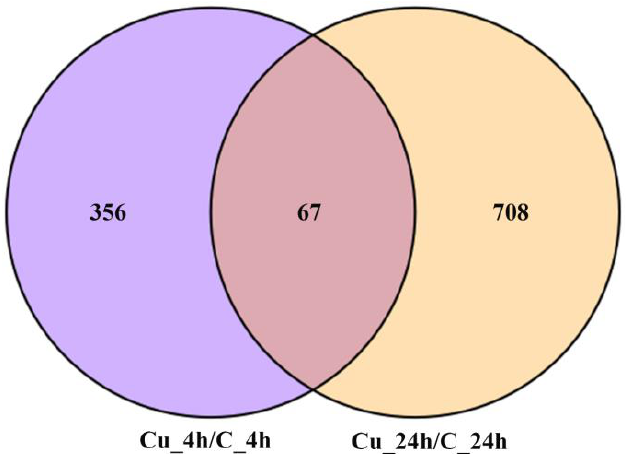
Figure 2. DEG distributions between two time points. Different colors represent different DEGs ex- pression distribution.